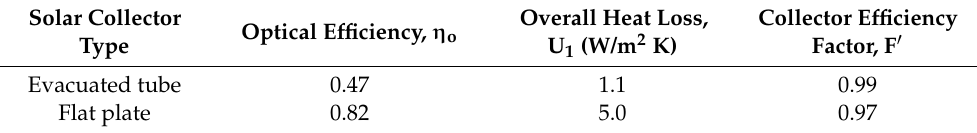
Table 3. Characteristic parameters for two kinds of solar collector [45].